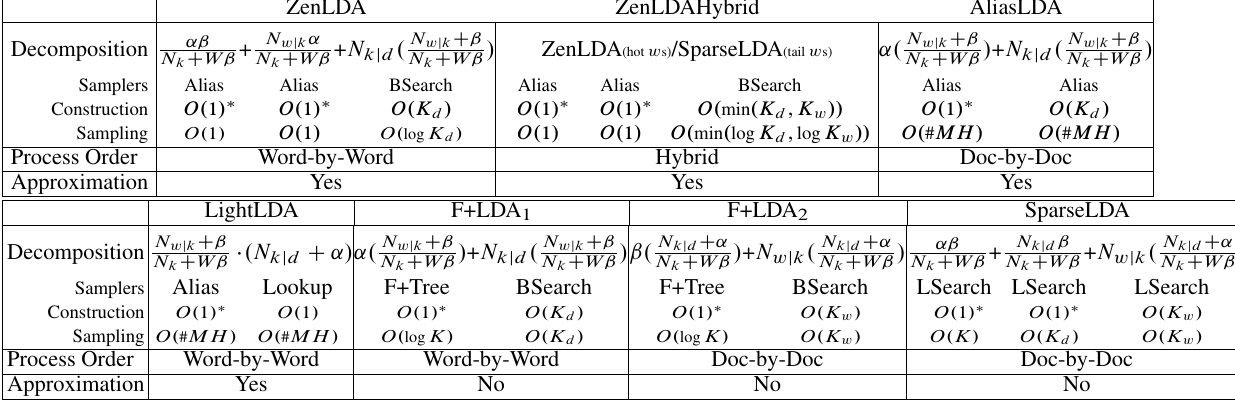
Table 2 Comparison of different LDA sampling approaches. O (1) * represents the computing complexity that can be amortized by each token. O (# MH ) means it depends on the complexity of the Metropolis-Hastings step. ZenLDA ZenLDAHybrid